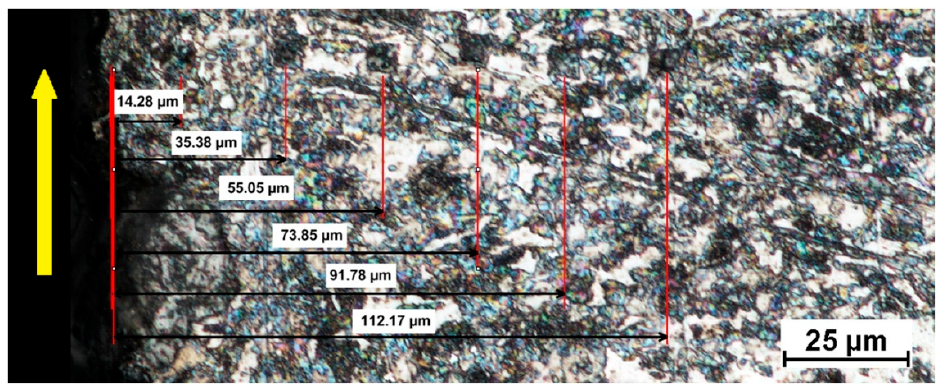
Figure 13. Metallographic microstructure with impressions at different distances from the line of cut (a pressure of 340 MPa and a cutting speed of 300 mm/min).